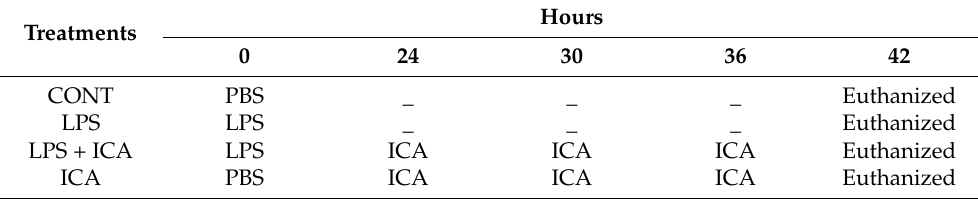
Table 2. Treatment